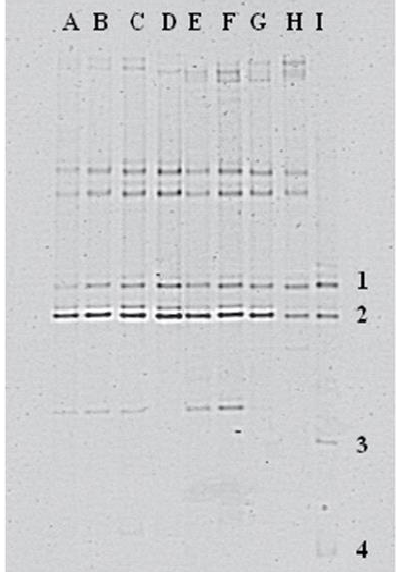
Figure 2. Examples of PCR-DGGE fingerprints obtained from the bulk suspensions. Lines A, B, C, D, E, F, G correspond to the samples coming from samples T-CS-I. Line I correspond to the standard used as a control: 1— Lb. curvatus , DSM 20019; 2— Lb. sakei , DSM 6333; 3— Lb. brevis , DSM 20054; 4— Lb. casei , DSM 20011.